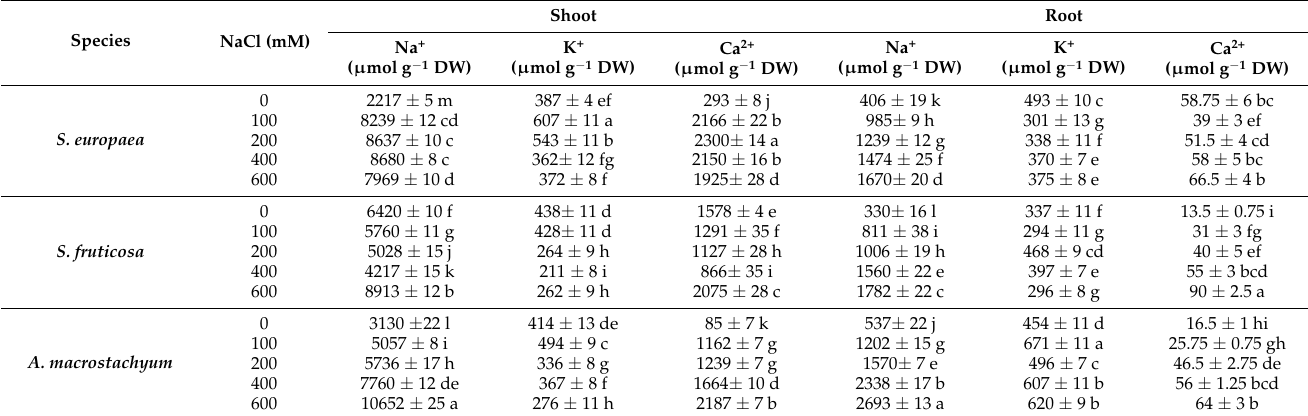
Table 1. Analysis of Na + , K + and Ca 2+ content ( µ mol/g DW) in root and shoot of namely Salicornia europaea , Sarcocornia fru- ticosa and Arthrocnemum macrostachyum under different salt concentrations. Different letters indicate significant differences. Species